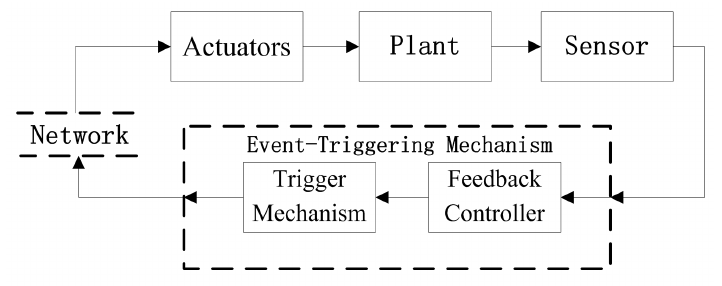
Figure 1. Architecture of the event-triggered network control